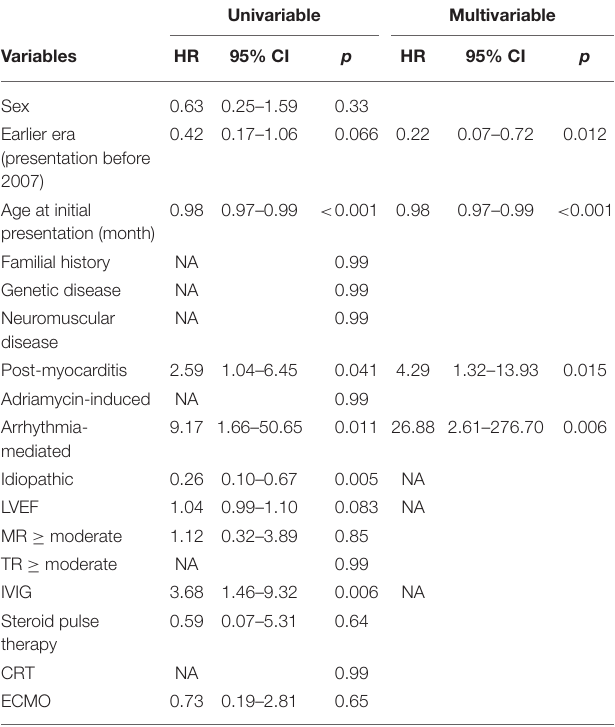
TABLE 3 | Predictors of functional recovery within 2 years after initial presentation. Univariable